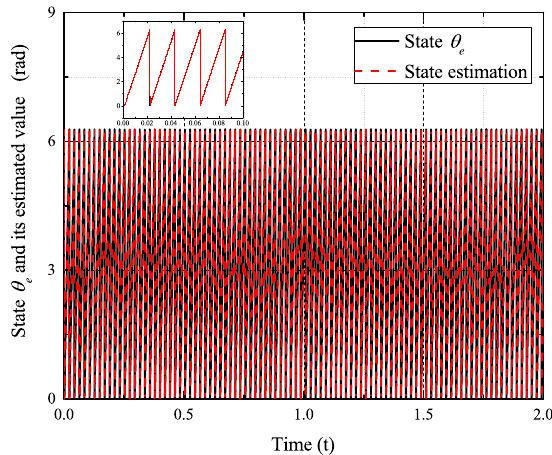
Figure 10. State θ e and its estimated value ˆ θ e .